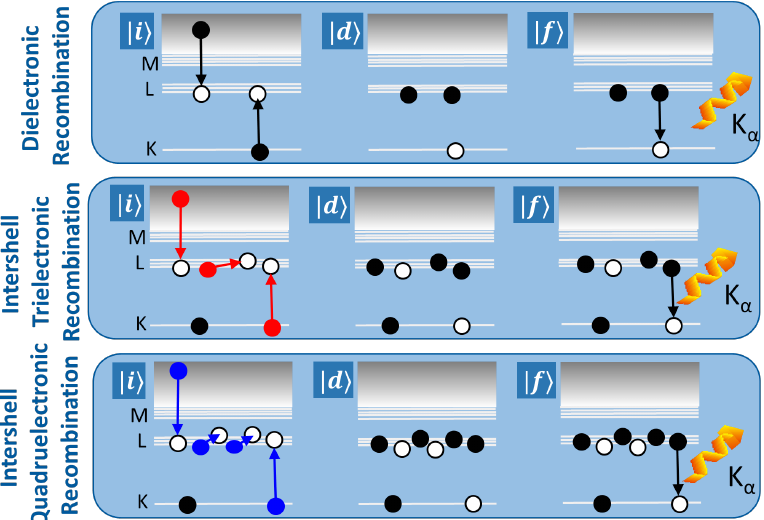
Figure 1. The two-step multielectron recombination processes for DR K-LL (top, black), TR KL-LLL (middle, red), and QR KLL-LLLL (bottom,